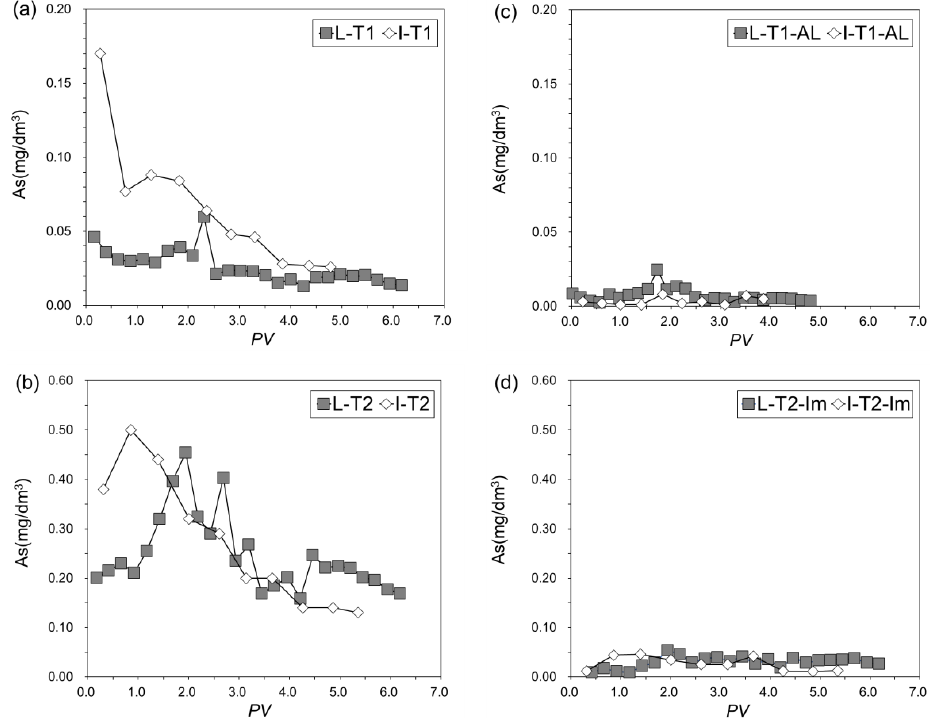
Figure 3. Changes in As concentrations with PV ; ( a ) comparison between L-T1 and I-T1, ( b ) comparison of L-T2 and I-T2, ( c ) comparison between L-T1-AL and I-T1-AL and ( d ) comparison between L-T2-Im and I-T2-Im.